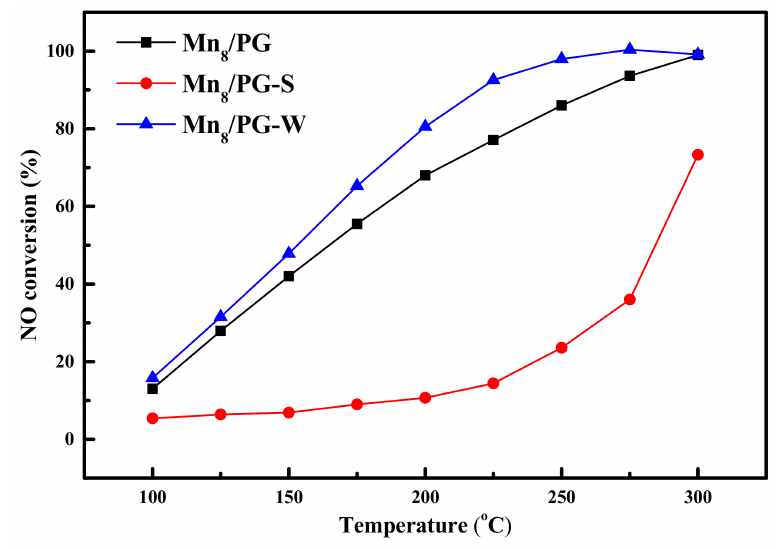
Figure 4. Selective catalytic reduction activity of different Mn 8 /PG catalysts. Reaction condi- tions: [NH 3 ] = [NO] = 600 ppm, [O 2 ] = 3 vol%, N 2 balance, GHSV = 7000 h − 1 , total flow rate = 350 mL min − 1 .